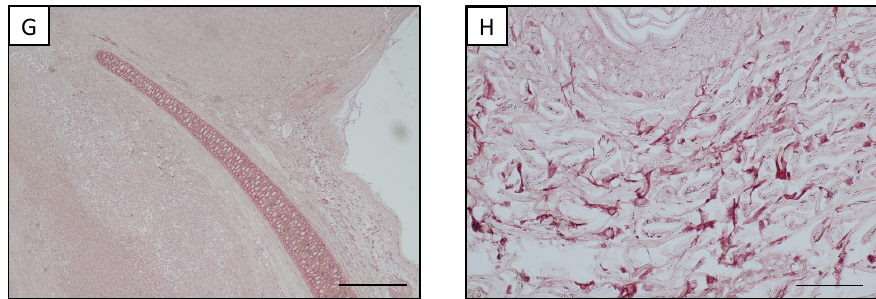
Figure 1. Auricular pinna, cat. ( A ) Presence of well-circumscribed neoplasms deep in the dermis. Hyperplastic epidermis was present in tissues adjacent to the neoplasm. HE. Bar = 500 µ m. ( B ) Fibrosarcoma. Intermediate-sized spindle cells arranged into storiform and vortex architectures. HE. Bar = 100 µ m ( C ) Hyperplastic epidermis with stratification disorders at the periphery of a well-circumscribed fibrosarcoma. HE. Bar = 500 µ m. ( D ) Higher magnification of hyperplastic epidermis with stratification disorders: proliferation nests (black circles). HE. Bar = 50 µ m. ( E ) Higher magnification of hyperplastic epidermis with stratification disorders: squamatization of the basal layer (yellow arrows). HE. Bar = 50 µ m. ( F ) Higher magnification of hyperplastic epidermis with stratification disorders: dysplastic keratinocytes in the basal layer. HE. Bar = 50 µ m. ( G ) Superficial dermis adjacent to the neoplasm showed elastosis. Orcein staining. Bar = 500 µ m. ( H ) Higher magnification of thickened, hypertrophic, fragmented and branched elastic fibers. Orcein staining. Bar = 100 µ m.